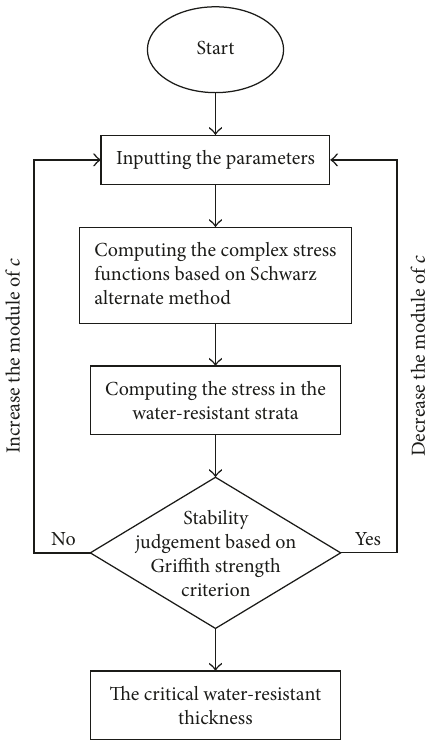
Figure 3: Flow chart to identify critical water-resistant